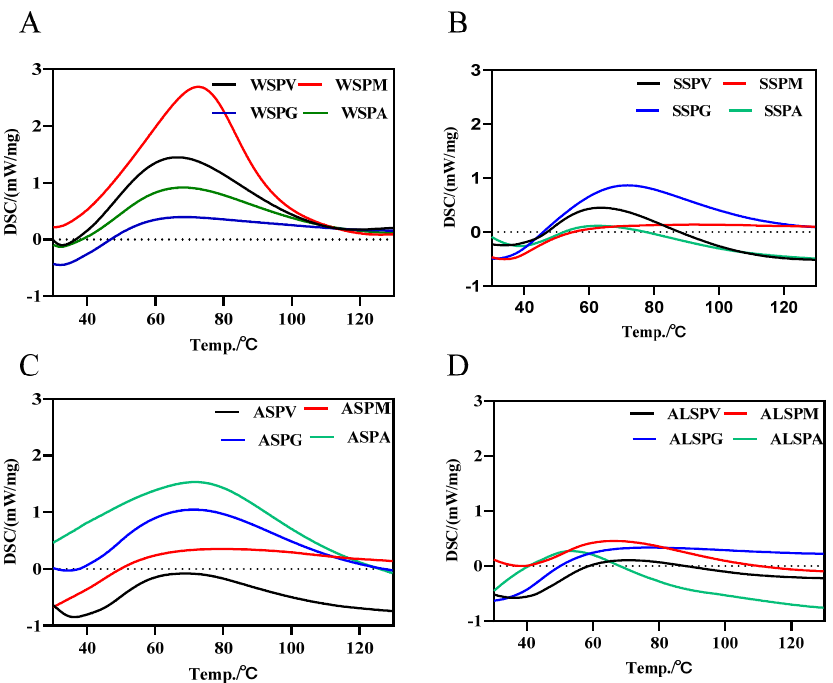
Figure 3. DSC profiles of protein components in different parts of the oyster. ( A ), DSC profile of WSP in different parts of oyster. ( B ), DSC profile of SSP in different parts of oyster. ( C ), DSC profile of ASP in different parts of oyster. ( D ), DSC profile of ALSP in different parts of oyster. WSPV, WSPM, WSPG, and WSPA are water–soluble proteins of the visceral mass, mantle, and adductor, respectively. SSPV, SSPM, SSPG, and SSPA are salt–soluble proteins of visceral mass, mantle, and adductor muscle, respectively. ASPV, ASPM, ASPG, and ASPA are acid–soluble proteins of the visceral mass, mantle, and adductor muscle, respectively. ALSPV, ALSPM, ALSPG, and ALSPA are alkali-soluble proteins of visceral mass, mantle, and adductor muscle, respectively.